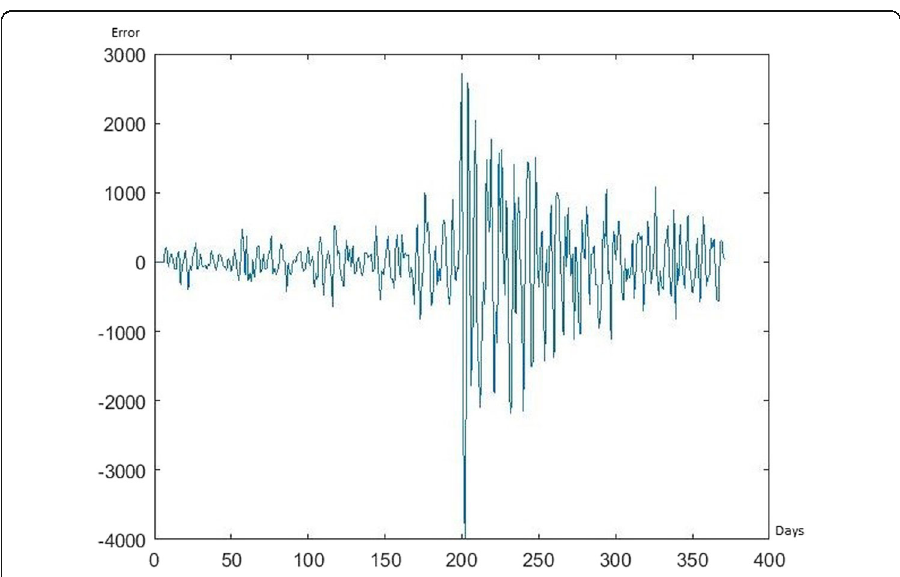
Fig. 1 Error of Bitcoin price in the period 1